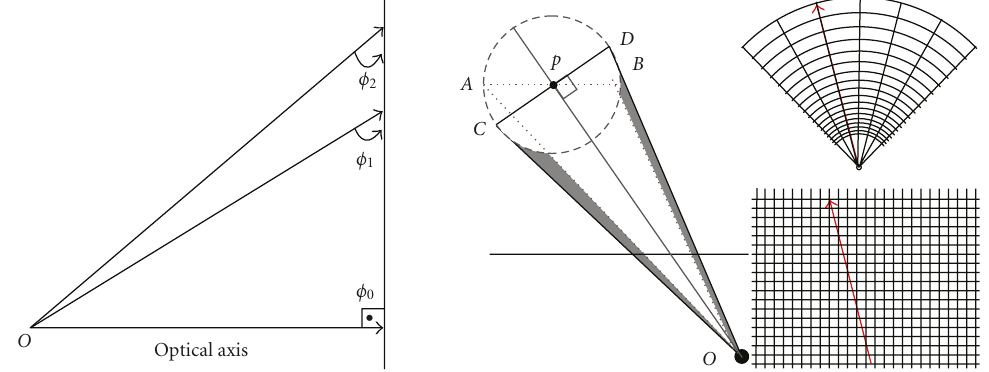
Figure 2: Flatland illustrations of the geometry of sphere sweeping. Left: A line of sight intersects a frontoparallel surface with increasing slant, as it moves from the center of the image ( φ 0 ) to its periphery ( φ 1 , φ 2 ). Center: The subtended visual angle of a small area centered at (cid:2) p is maximized when this area is perpendicular to the line of sight from the projection center (cid:2) o to (cid:2) p and is less otherwise. Right: Illustrations of the sector-(top) and voxel-(bottom) based volume tessellations. Visibility is naturally expressed in the first representation, whereas in the second, traversing voxels obliquely is required for its